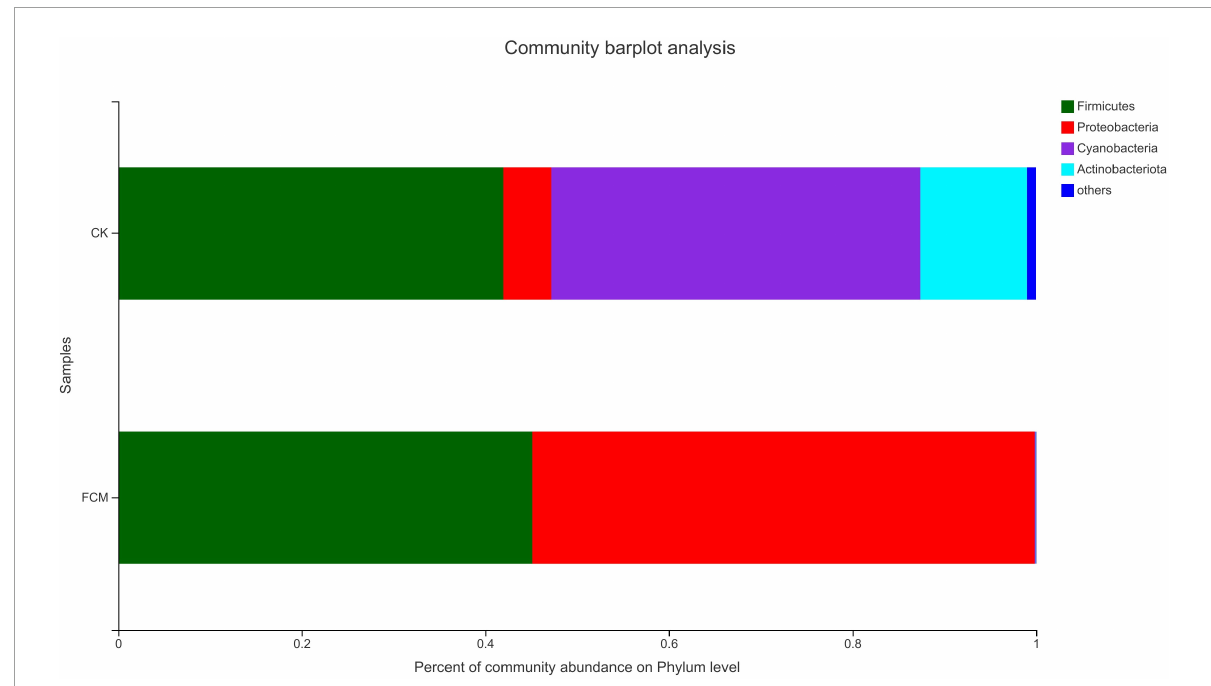
FIGURE7 Column diagram of bacterial community at the phylum level. The abundance is represented in terms of the percentage of the total effective bacterial sequences in the sample [CK: cottonseed meal (CM); fermented cottonseed meal (FCM): FCM].